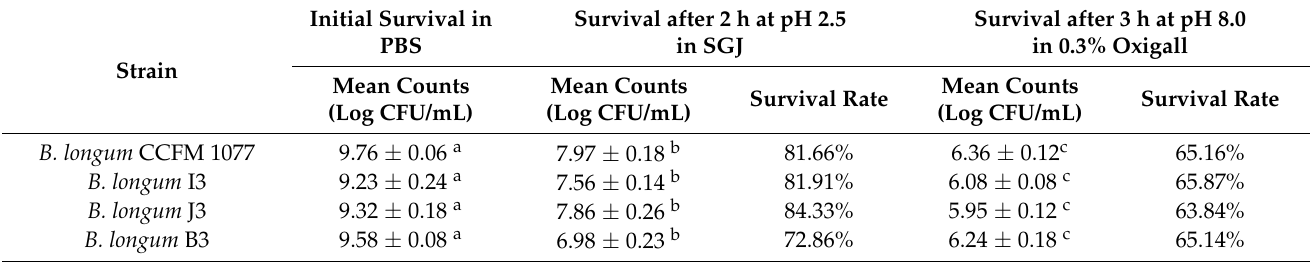
Table 1. Tolerance of four B.longum strains to simulated gastroenteric